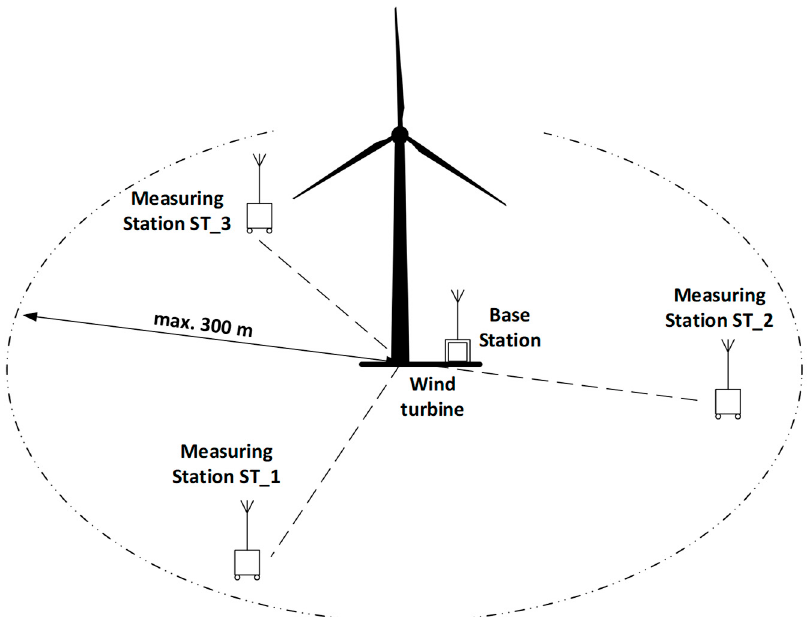
Figure 3. General functional diagram of the INFRA system for the measurement of low-frequency signals generated by wind turbines (study results).